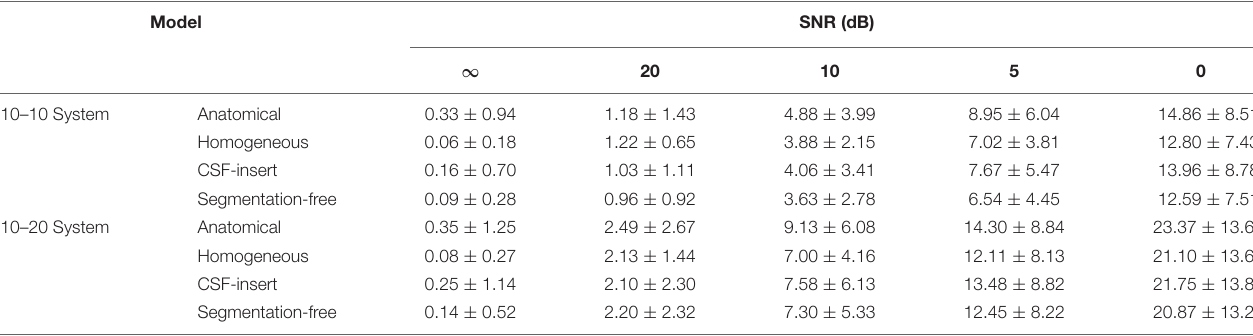
TABLE 4 | Mean localization error of results presented in Figure 4 .